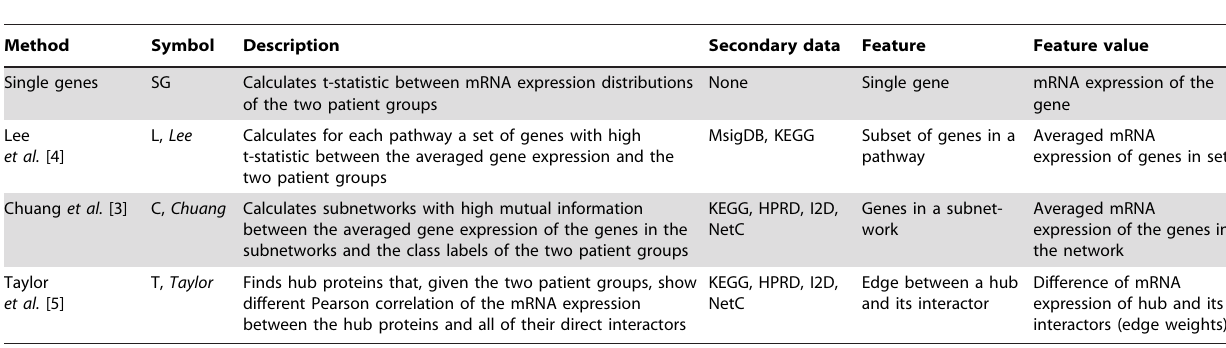
Table 1. Overview of evaluated feature extraction